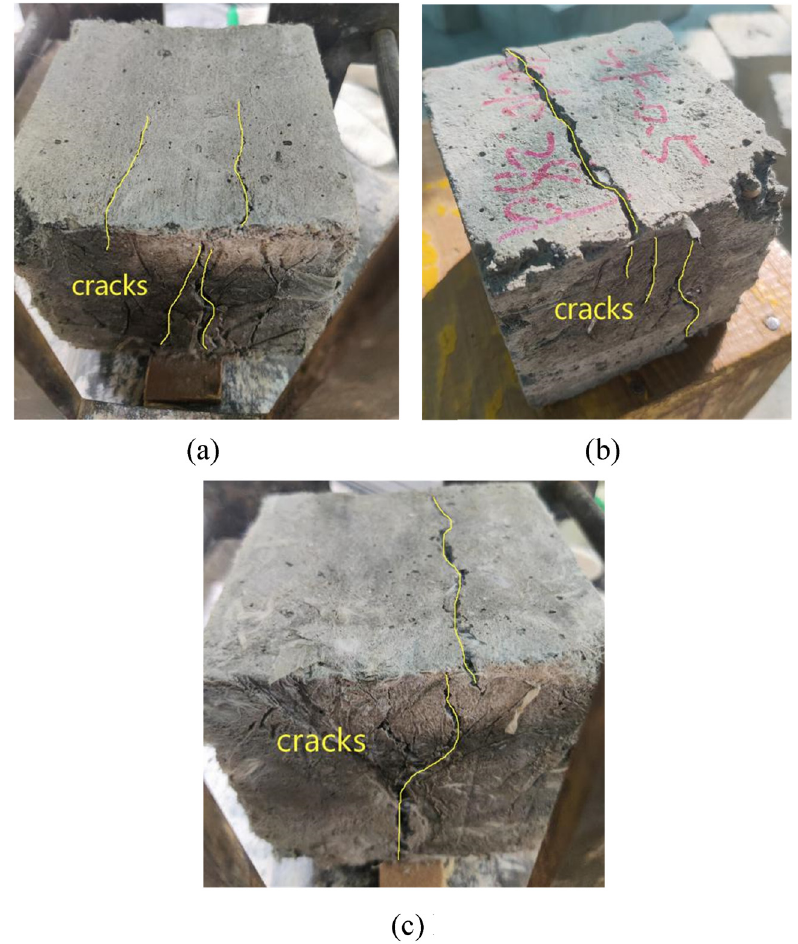
Figure 11: Control groups. ( a ) BFCGGPC, ( b ) SFCGGPC, and ( c )